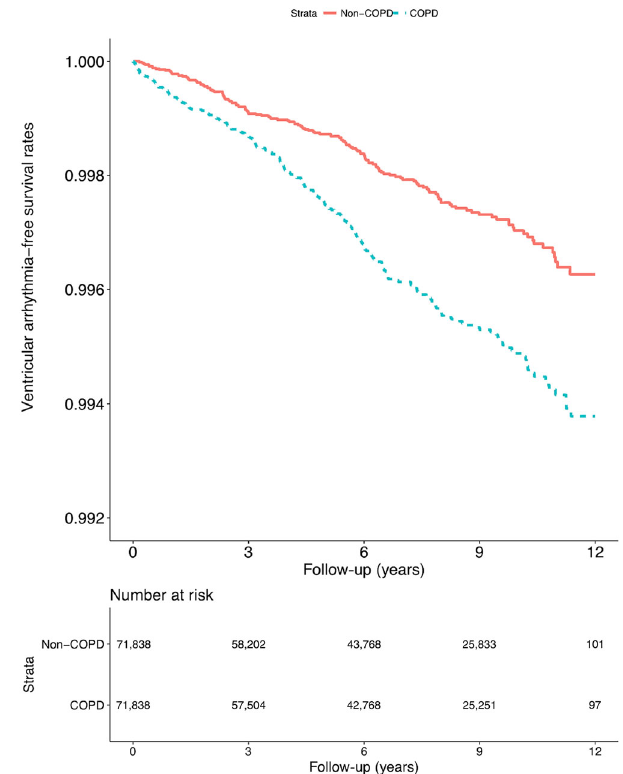
Fig. 2 VA admission events in the study cohort ( n = 143,676) from 1 January 2001 to 31 December 2012 in Taiwan. Data were strati fi ed by COPD and non-COPD (log-rank test, χ 2 = 31.254; df = 1; p <